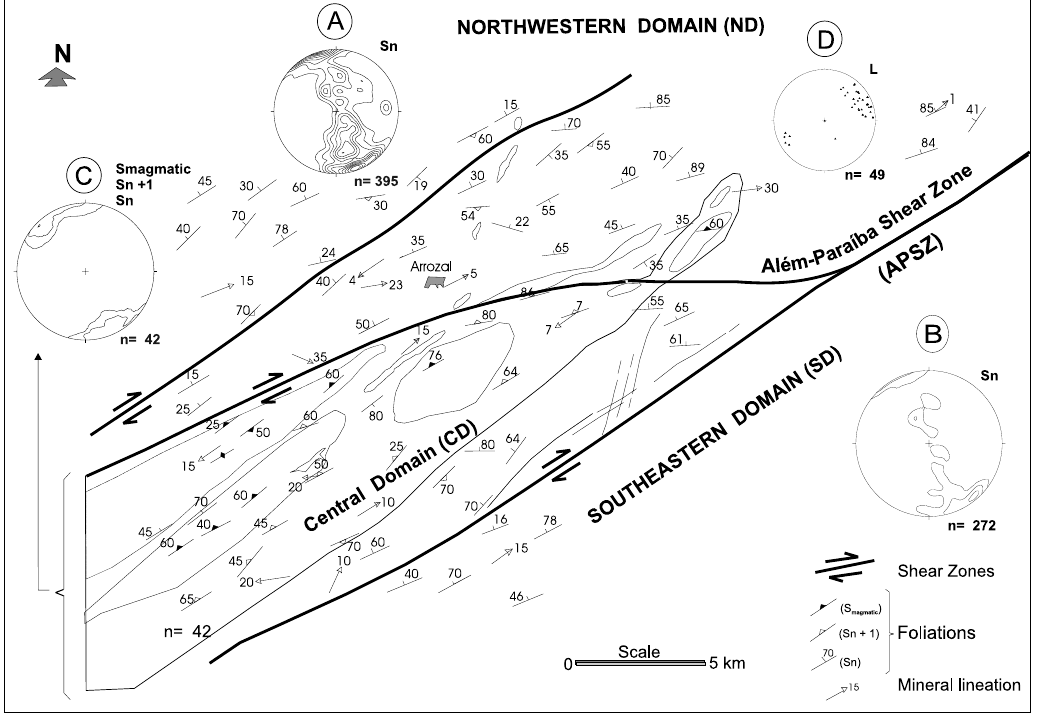
Fig. 2 – Structural map of the Arrozal Granite and its surroundings, southwestern region of the State of Rio de Janeiro, with stereographic plots (lower hemisphere projections) of three structural domains: (A) and (B) Sn foliation (gneissic banding), (C) magmatic foliation (S magmatic ) and foliation in the solid-state (Sn+1) and (D) Mineral stretching